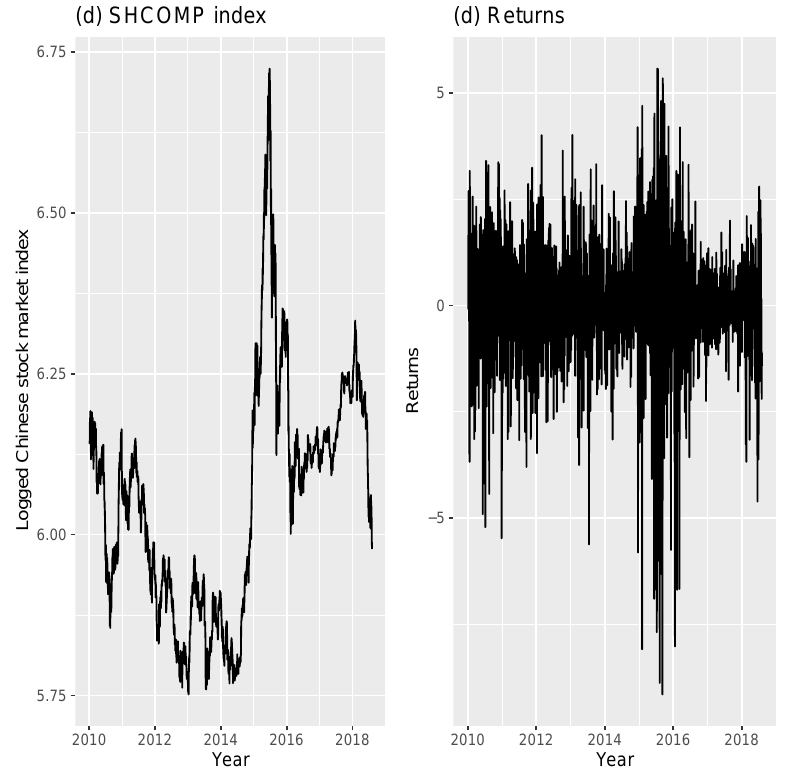
Figure 4. ( Left ) Plot of the Chinese stock market index; ( Right ) Plot of the returns.